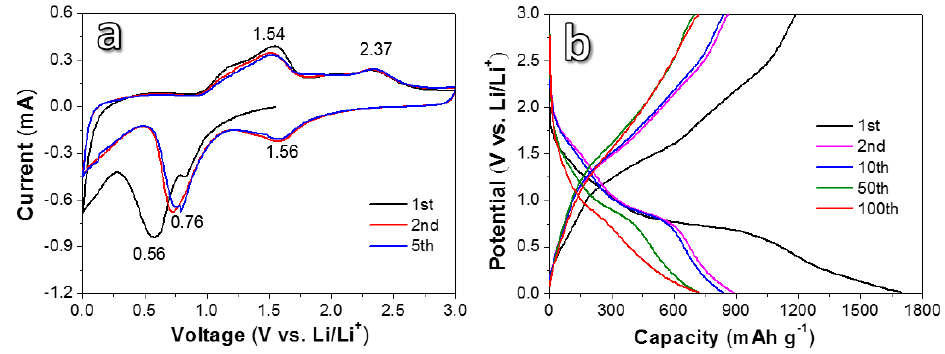
Figure 5. Cyclic voltammetry (CV) ( a ) and galvanostatic charge / discharge ( b ) curves of the products dealloyed for 24 h.